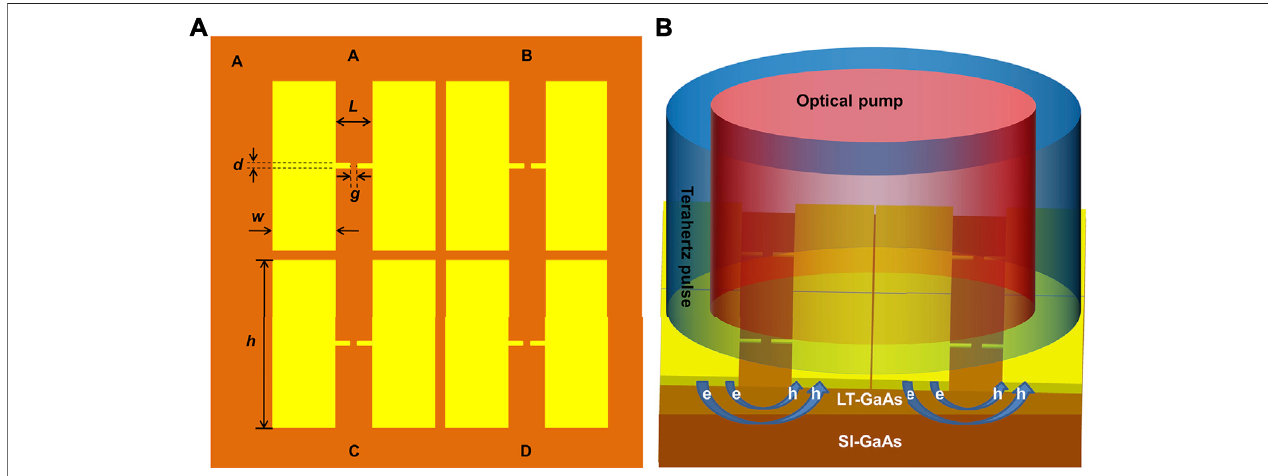
FIGURE1| Construction anduse of2 × 2photoconductiveantenna array: (A) Design structure of2 × 2photoconductiveantennaarray. (B) Schematicdiagramof irradiation by laser and terahertz wave.